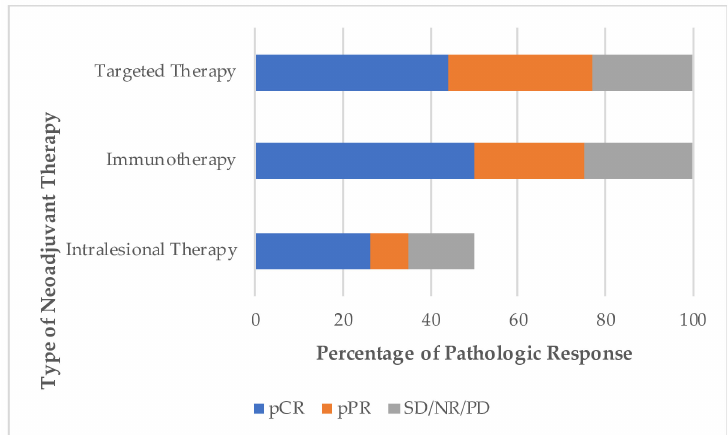
Figure 3. Pathologic response by type of neoadjuvant therapy. pCR, pathologic complete response, no evidence of viable tumor cells on complete pathological evaluation of the surgical specimen. pPR, pathologic partial response, less than 50% viable tumor cells on complete pathological evaluation of the surgical specimen. NR, non response, more than 50% viable tumor in the surgical specimen. SD, stable disease. PD, progression of